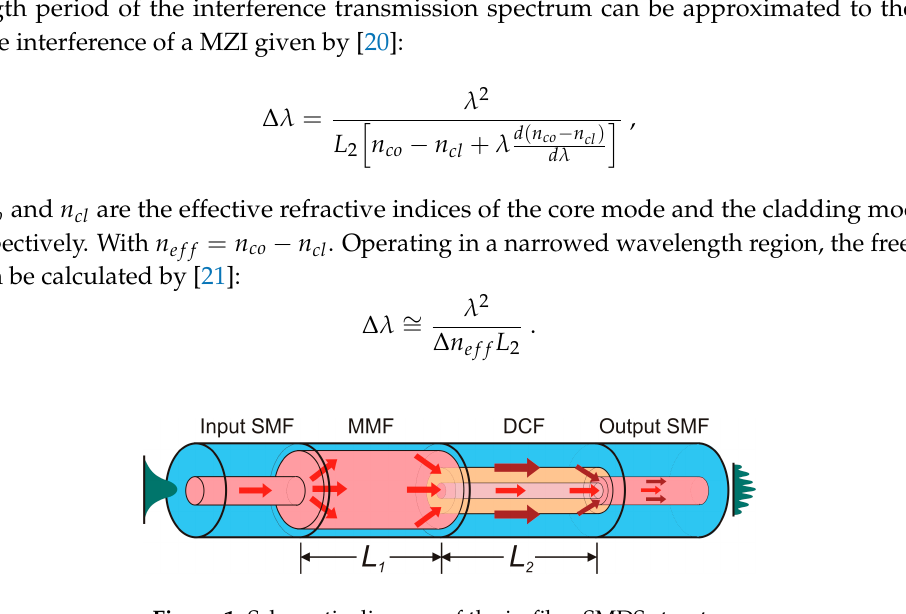
Figure 1. Schematic diagram of the in-fiber SMDS structure.